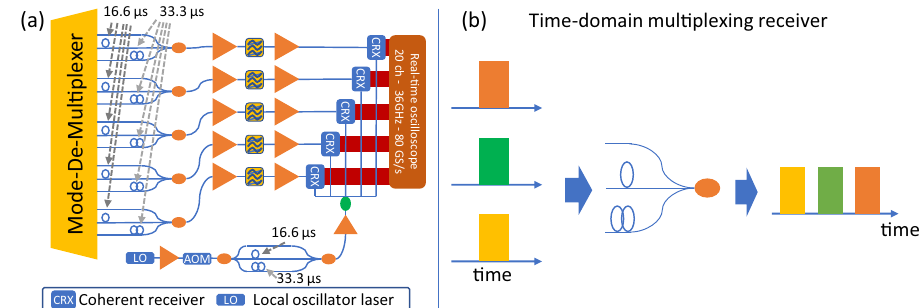
Fig. 7 Laboratory implementation of the 15-mode receiver. a Groups of three output ports from the mode de-multiplexer were combined in power couplers after delaying two ports by 16.66 and 33.33 μ s, respectively. This enabled the reception of all 15 output ports in fi ve coherent receiver sub-systems that contained optical bandpass fi lters to select a WDM channel under test, EDFAs and a common local oscillator laser. Symbol de fi nitions as in Fig. 6. b Schematic description of the 3 × 1 time-division multiplexing receiver